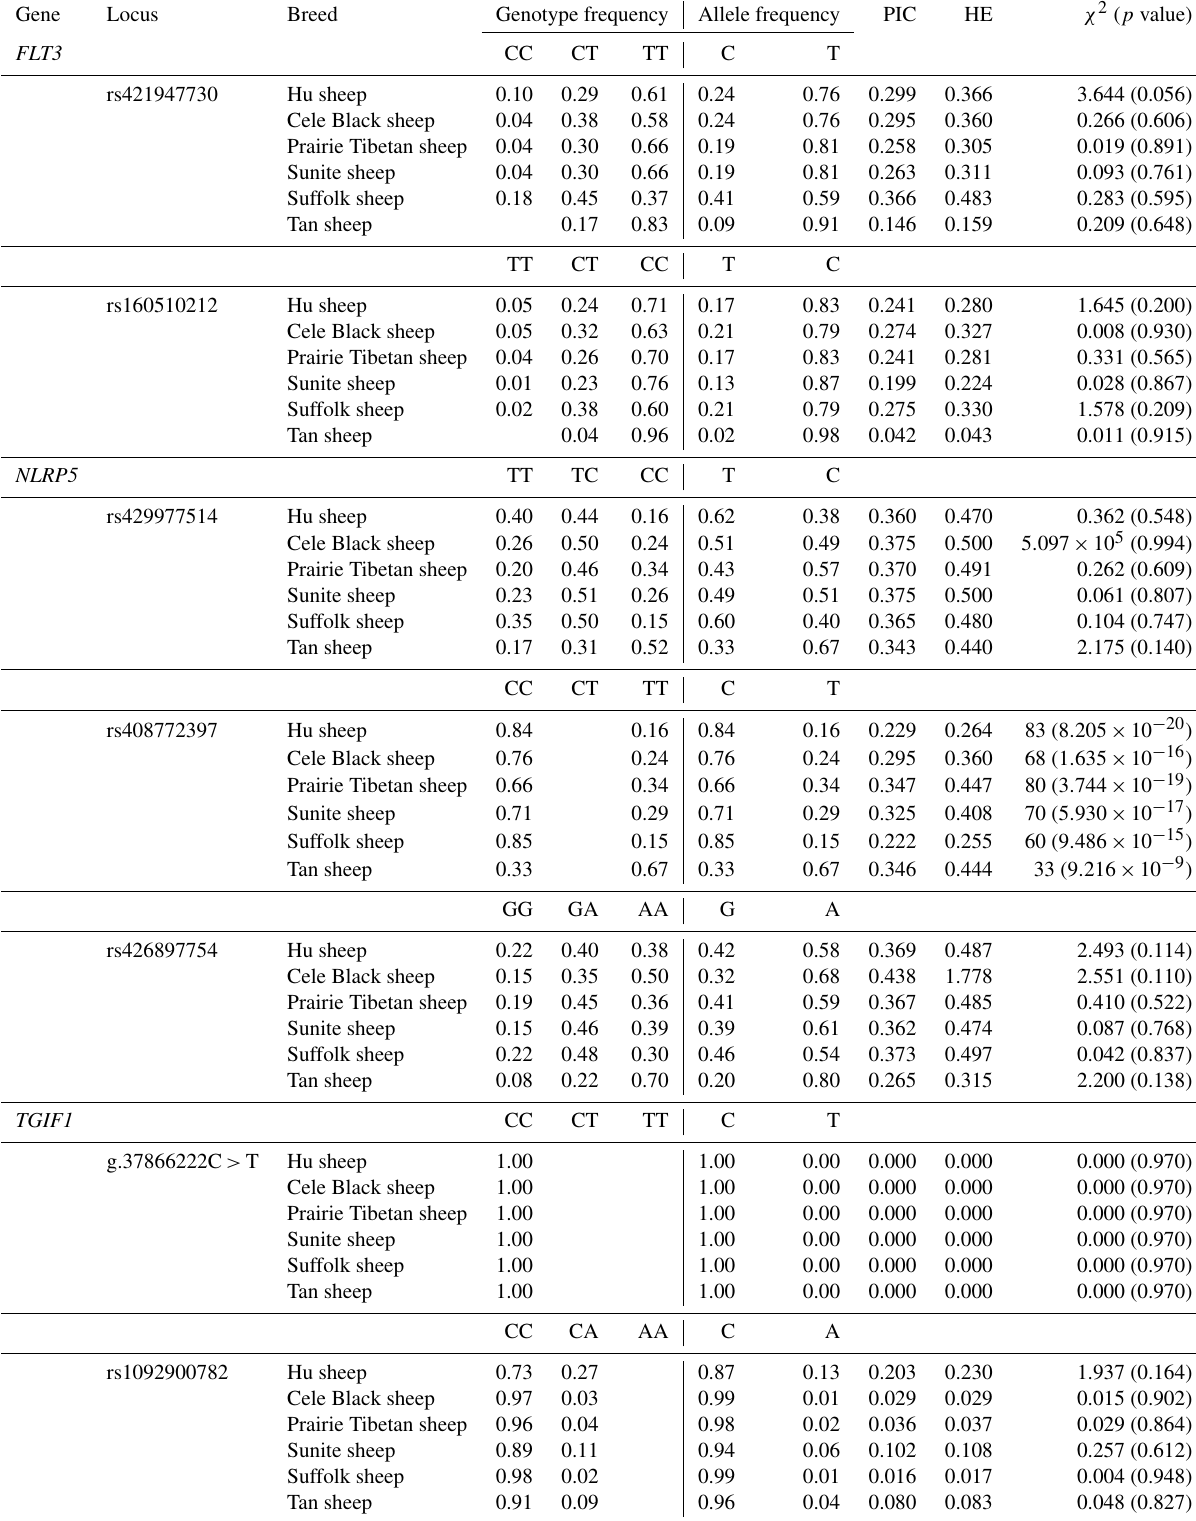
Table 3. Population genetic analysis of seven SNPs in six sheep breeds. Gene Locus Breed Genotype frequency Allele frequency PIC HE χ 2 ( p value) FLT3 CC CT TT